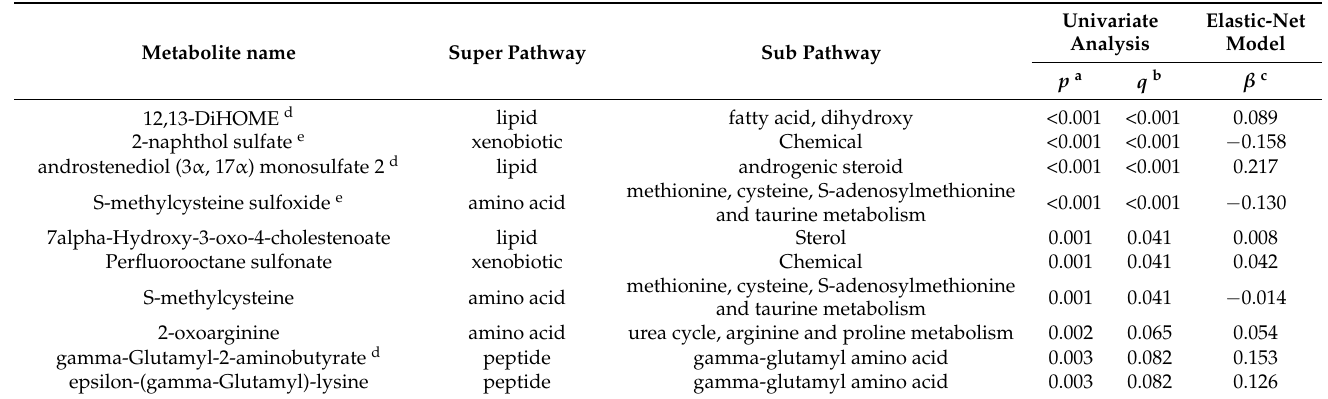
Table 2. Selected markers of long-term red meat consumption.